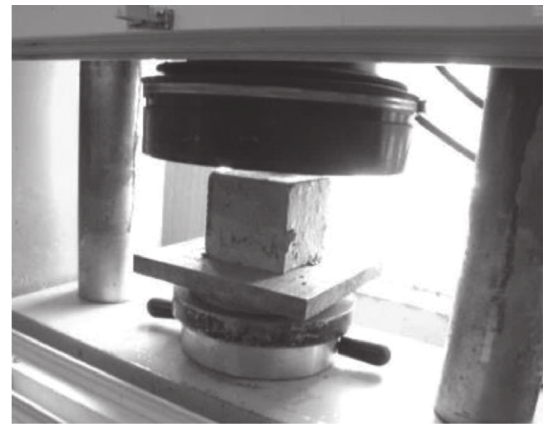
Figure 2: Specimen under compression machine.